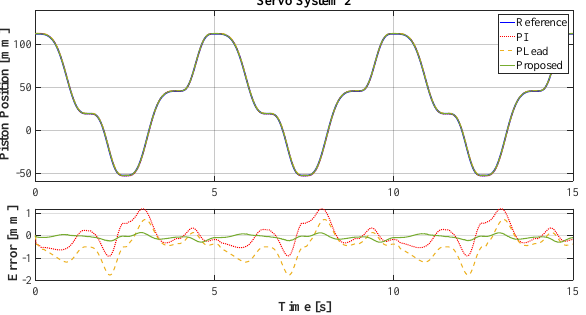
Figure 4: Simulated response for servo system 2, with velocity feedforward included with linear controllers.